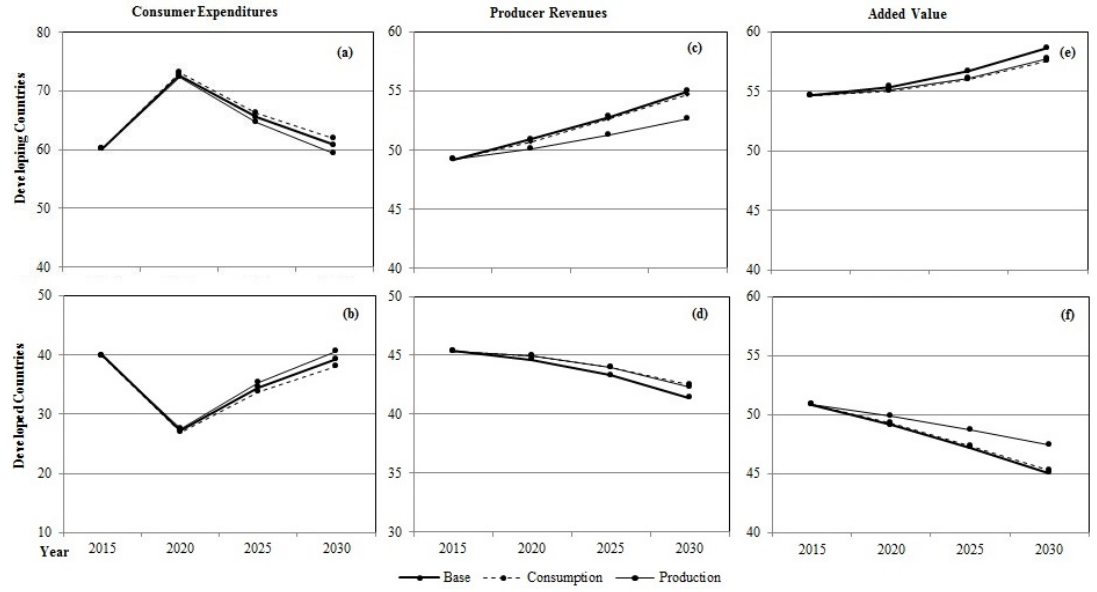
Figure 3. Changes of shares of consumer expenditures in ( a ) developing countries; ( b ) developed countries under each scenario. Changes of shares of producer revenues in ( c ) developing countries; ( d ) developed countries under each scenario. Changes of shares of added value in ( e ) developing countries; ( f ) developed countries under each scenario. Note: all values are reported as percentages.